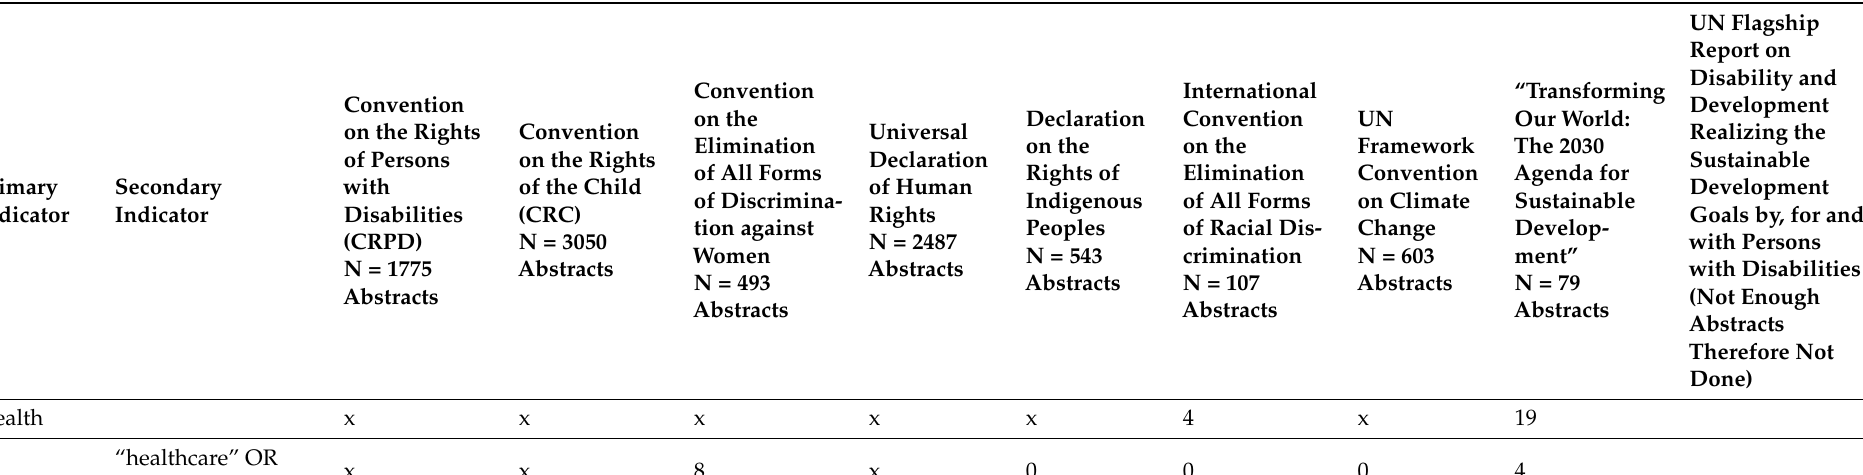
Table 11. Presence of Community Based Rehabilitation Matrix indicators in abstracts mentioning “the